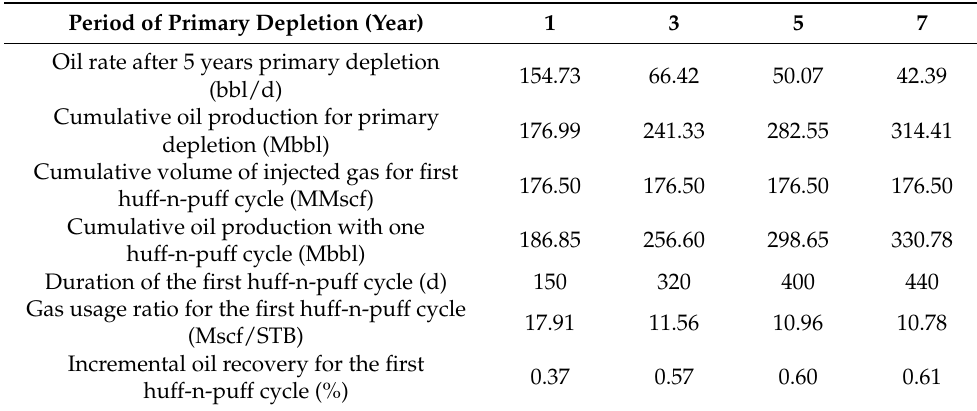
Table 17. Summary of results for huff-n-puff with different primary depletion